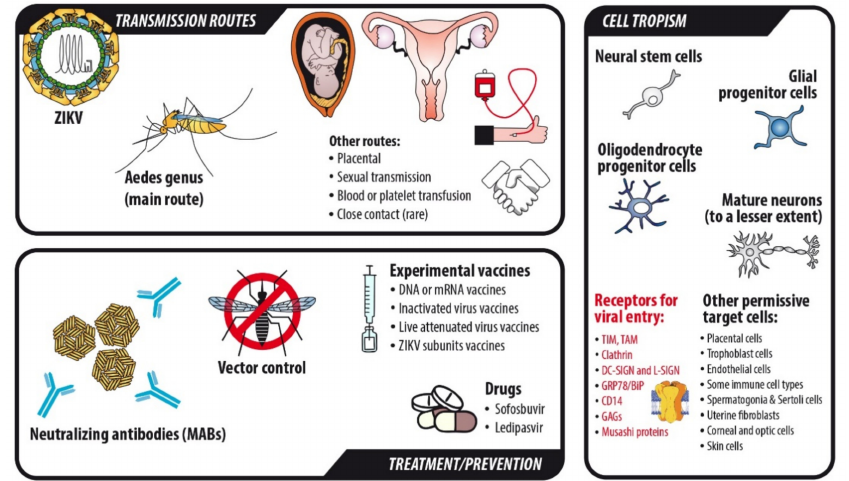
Figure 1. Summary of the transmission routes, cell targets and actual treatments for Zika virus (ZIKV). The life cycle of ZIKV is very similar to that of other viruses from the Flavivirus